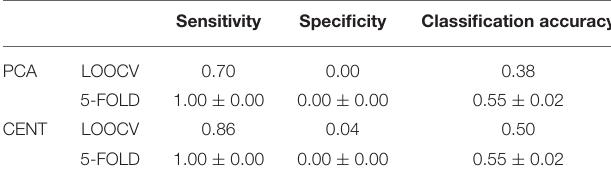
TABLE 4 | Sensitivity, specificity and classification performance of the tensorial treatment of ML-FCG CorrEnv using two ROI representation and two cross-validation